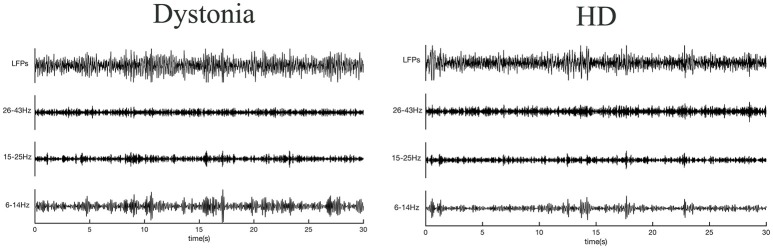
Raw local field potentials (LFPs) from dystonia and HD patients. Signals predominantly within 6–14, 15–25, and 26–43 Hz bands are presented.